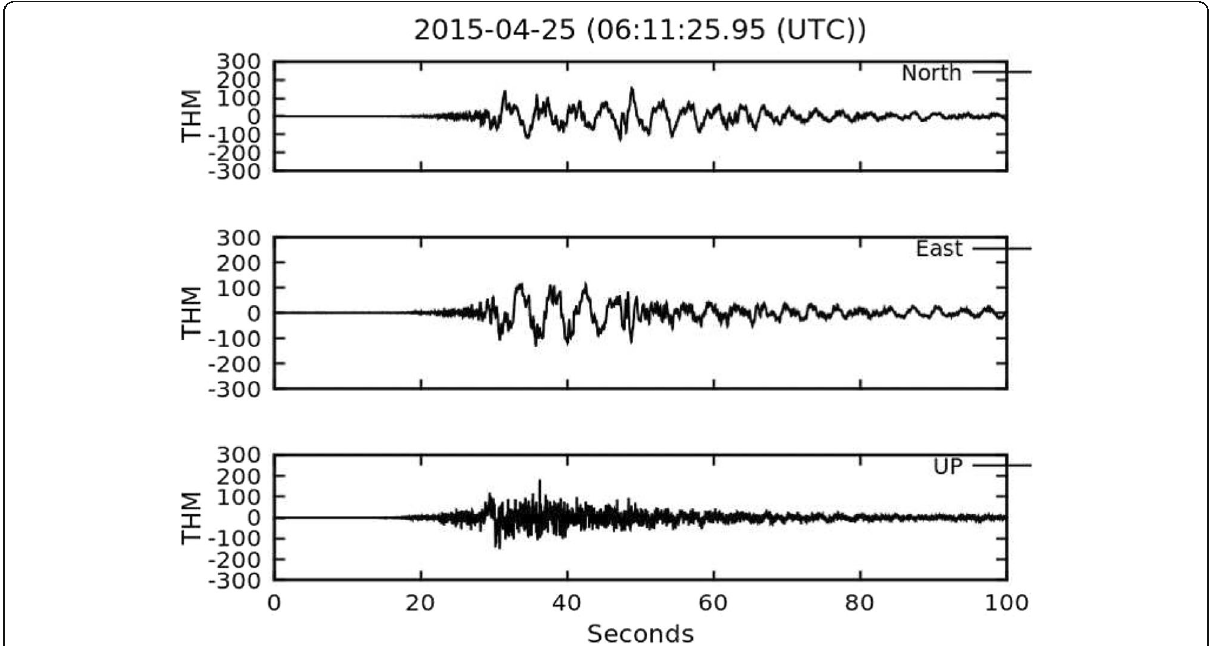
Fig. 5 Ground acceleration waveform recorded at station THM. The x-axis and y-axis represents time scale in seconds and ground acceleration in cm/s 2